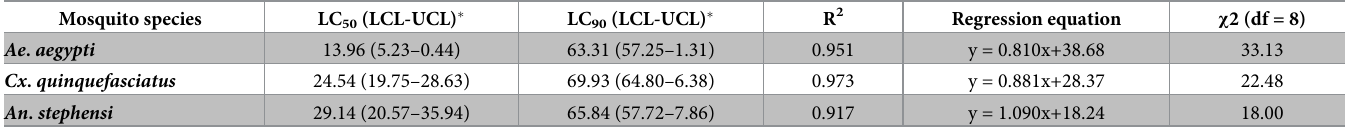
Table 3. Lethal concentrations, R 2 , Regression equations and χ 2 values for Ovicidal activity of AgNPs synthesized by Bacillus marisflavi against Ae . aegypti , Cx . quinquefasciatus and An . stephensi